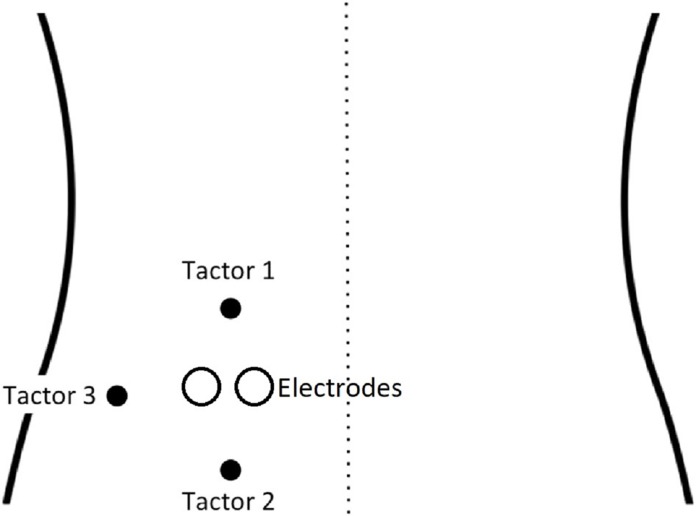
Set-up of vibrotactors and the electrodes on the back (adapted with permission from Madden et al. (2016a)).